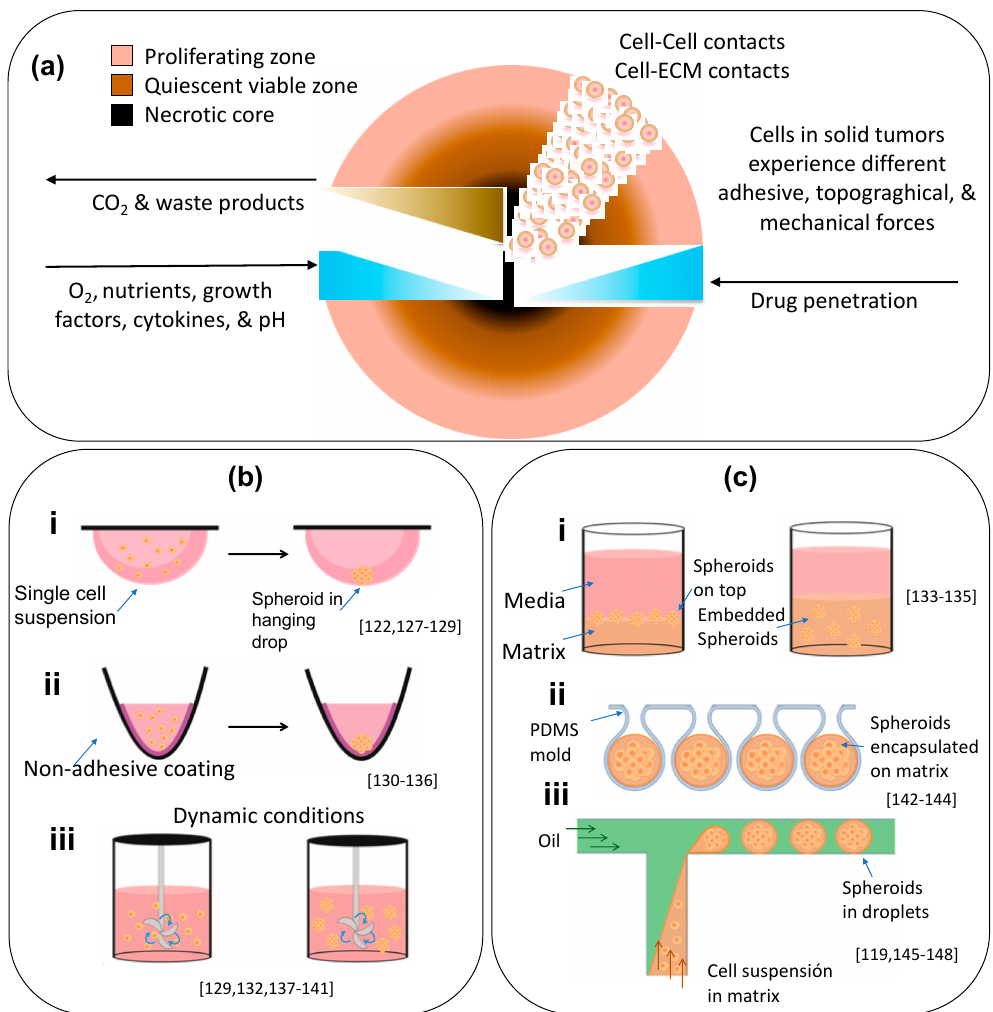
Figure 2. Architecture of tumor spheroids and their fabrication techniques. ( a ) Schematic representation of the 3D architecture of a tumor spheroid. Modified from Sant and Johnston 2017 [126]; ( b ) Fabrication of spheroids by the following scaffold-free methods: (i) hanging drop [122,127–129], (ii) liquid-overlay method [130–136], and (iii) force-driven method [129,132,137–141]; ( c )